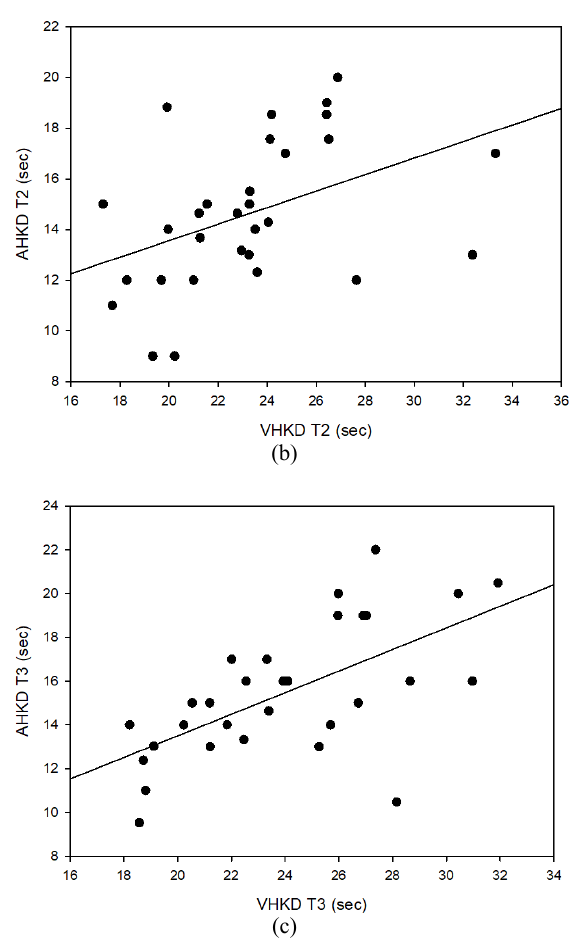
Figure 13. Correlation between VHKD and AHKD (a) Test 1, (b) Test 2, (c) Test 3 Error Frequency between K-D tests Comparison of Error Frequency by Type in Test